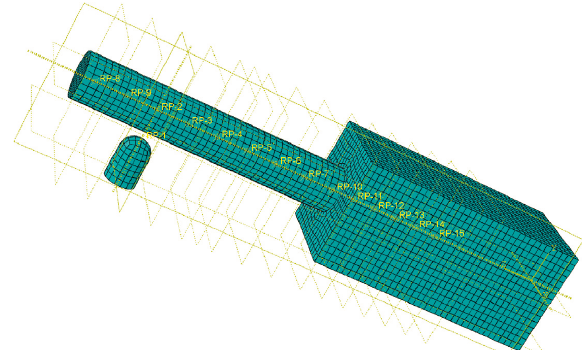
Figure 2: Mesh generation of